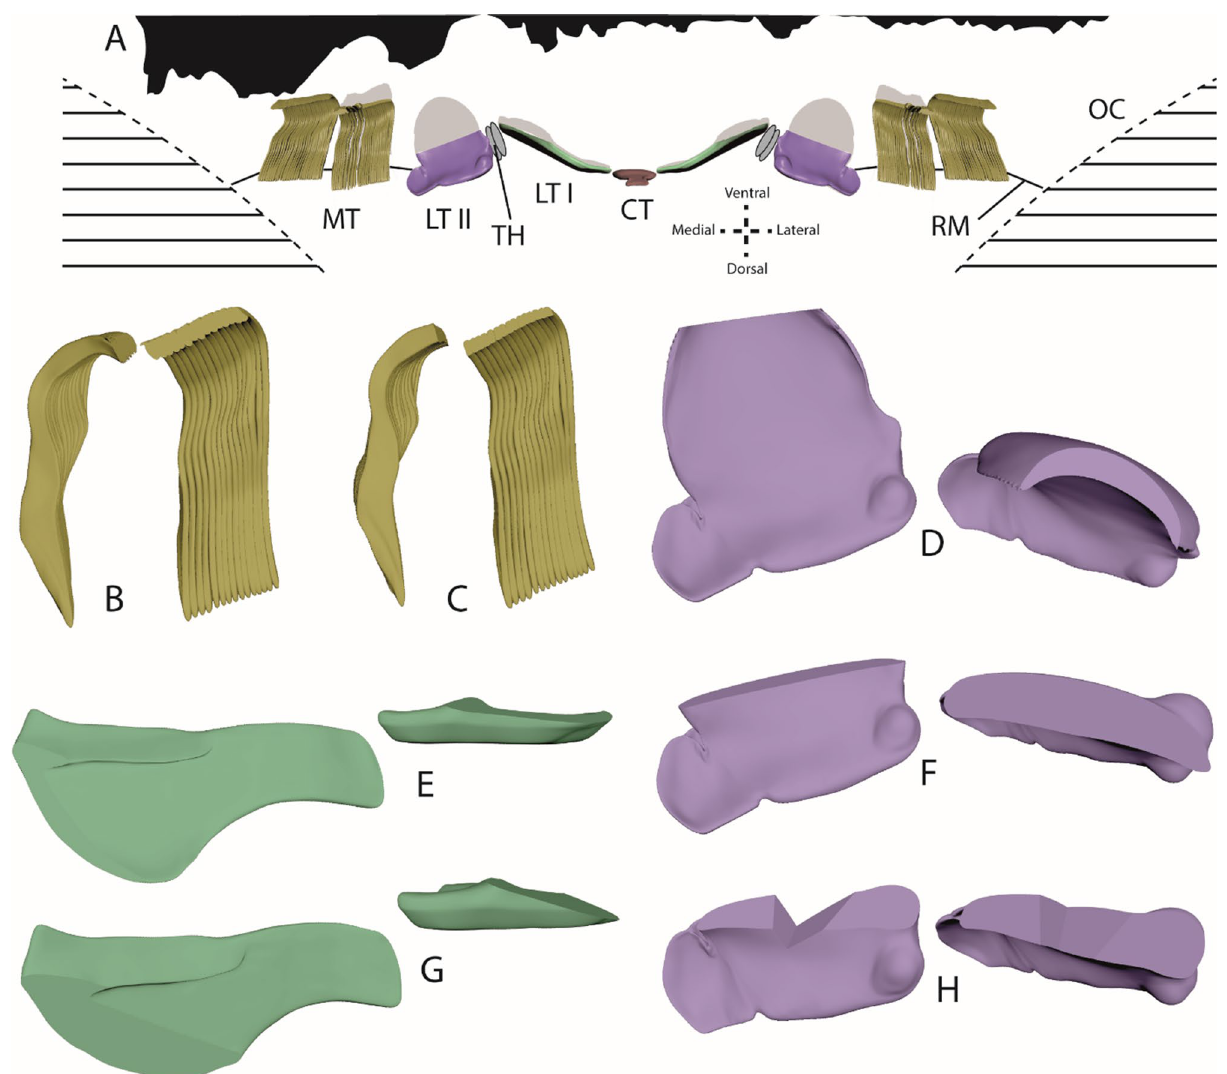
Figure 10. ( A ) Visualization of proposed position of the maximally worn teeth on radular membrane, between the two odontophoral cartilages, from frontal view (see axis for anatomical orientation). Silhouettes (drawn with Adobe Illustrator CS 6) of sandpapers used (from left to right: rough, medium, fine) are scaled identically to dimensions of teeth. In grey are silhouettes of unworn teeth. B–H. Some representable 3D models with worn condition ( B – C ) inner 15 marginal teeth, D, F, H. lateral tooth II, E, G. lateral tooth I). ( B ) Wear on 5th tooth row induced by rough sandpaper. ( C ) Wear on 1st tooth row induced by fine sandpaper. ( D ) Wear on 7th tooth row induced by medium sandpaper. ( E ) Wear on 1st tooth row induced by medium sandpaper. ( F ) Wear on 3rd tooth row induced by medium sandpaper. ( G ) Wear on 1st tooth row induced by fine sandpaper. ( H ) Wear on 1st tooth row induced by fine sandpaper. See Table 3 for volume loss in